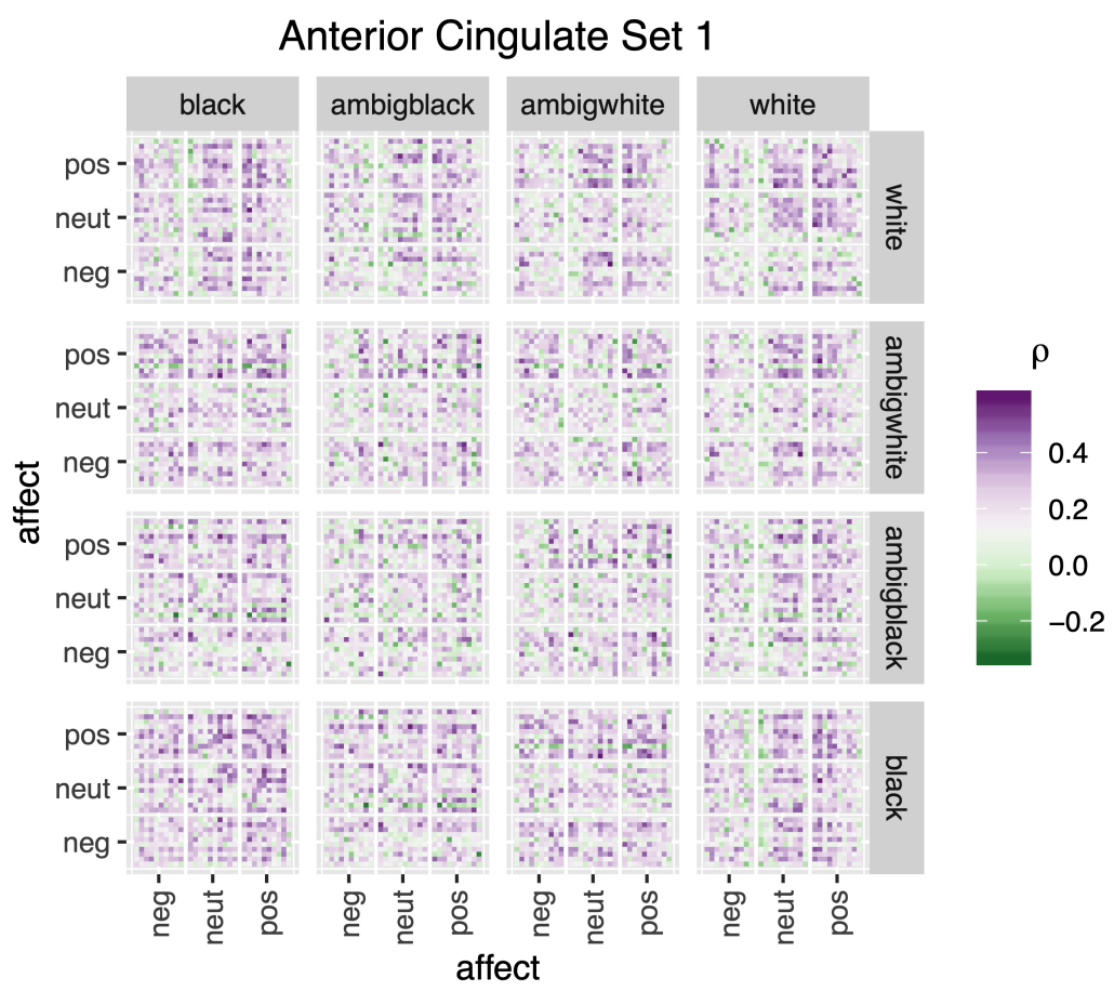
Figure A1. Representational similarity analysis of neural firing in the anterior cingulate cortex to face pairs, grouped first by race, then by affect. Each pixel represents the Pearson’s correlation coefficient for image pairs, with race and affect determined by the pixel’s position along the x and y axes (except for pixels with identical images in the pair, wherein the variance is shown). Stronger correlations are observed for the white-white and black-black pairs.